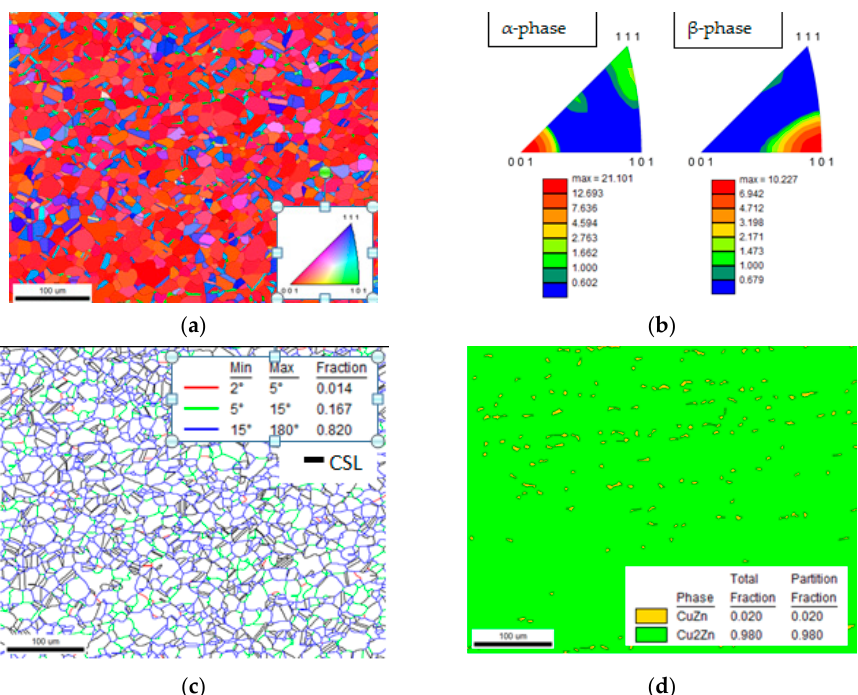
Figure 5. CuZn38As alloy in the as-drawn condition. ( a ) Inverse pole figure (IPF-Z) map and ( b ) texture plot. ( c ) Misorientation and ( d ) phase map. Note: CuZn ( β -phase), Cu2Zn ( α -phase).